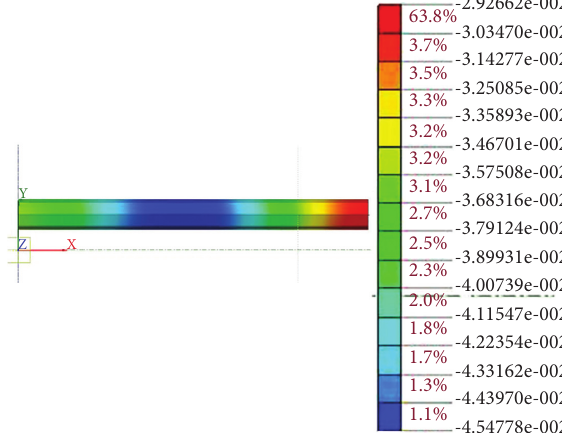
Figure 5: Pipeline deformation cloud map.